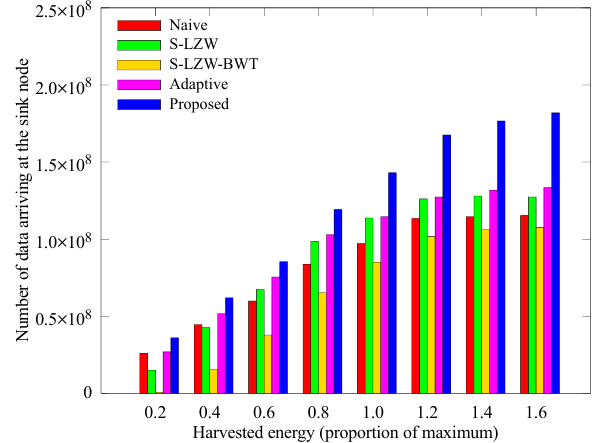
Figure 16. Comparison of the number of data obtained according to the solar